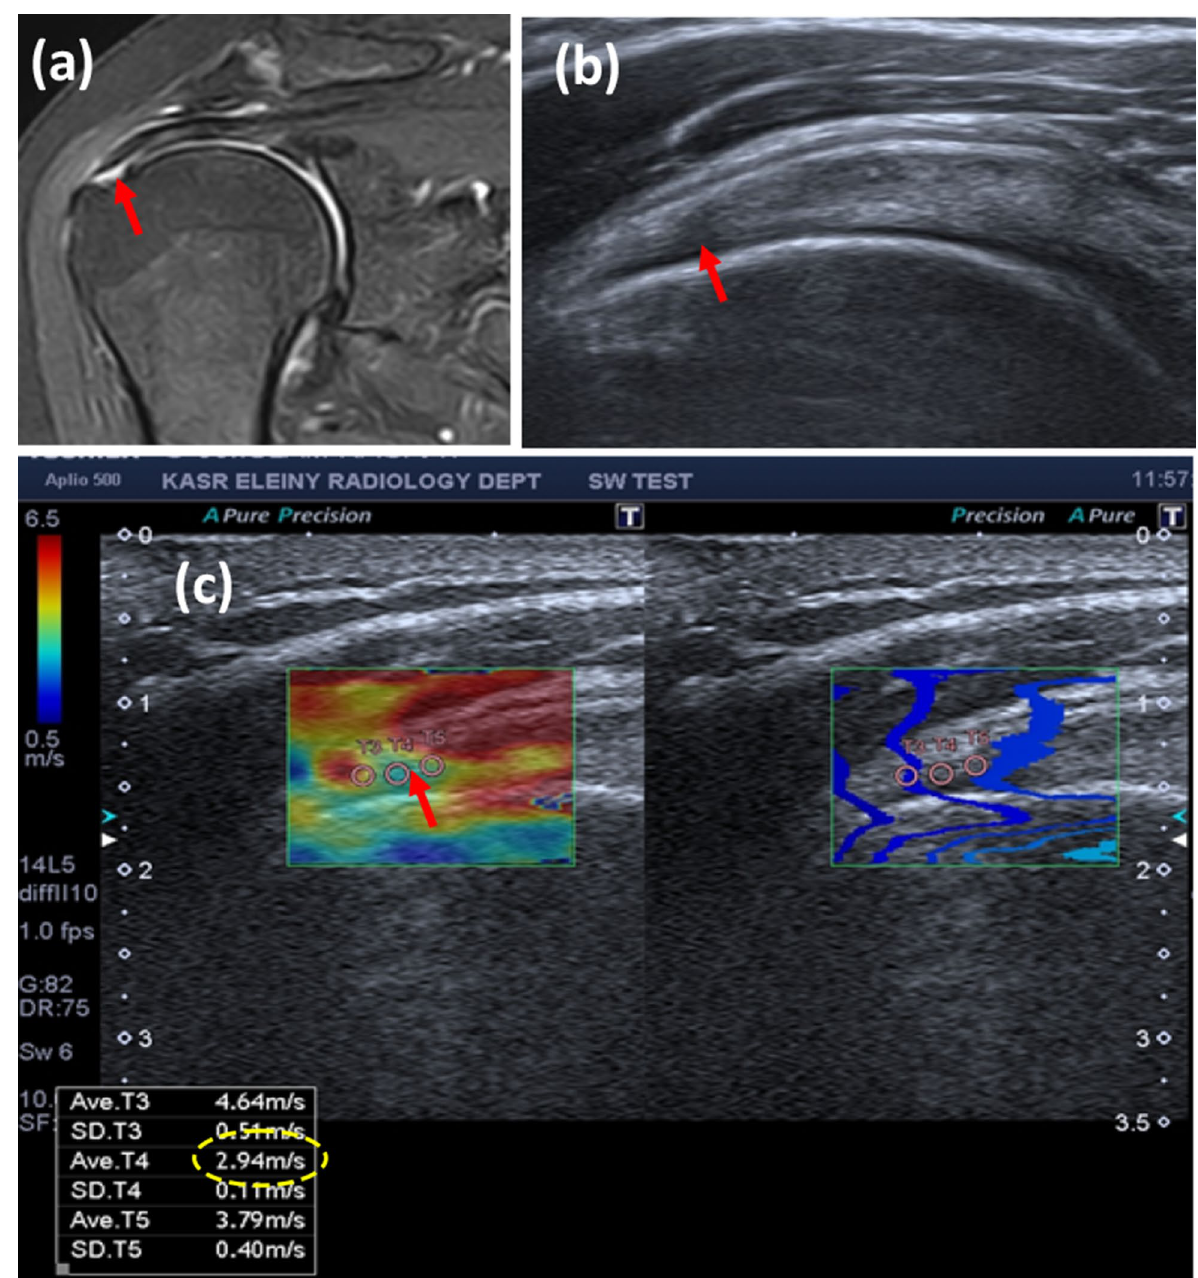
Fig. 6 a MRI coronal oblique STIR images of supraspinatus tendon showing intrasubstance increased signal with fluid signal seen disrupting the articular surface fibers (small articular surface tear grade III). b B-mode ultrasound of supraspinatus tendon showing hypoechoic area within the tendon reaching its articular surface. c SWE images showing focal area of tendon softening (blue color reaching its articular surface). SWV equals 2.9 m/s (dashed